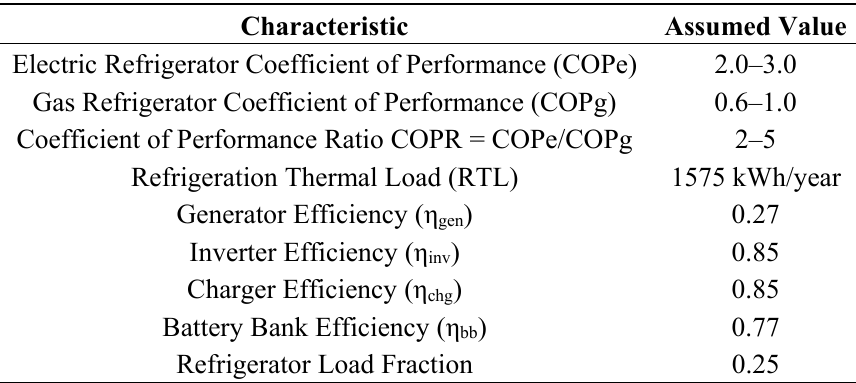
Table 2. Assumed values for component performance